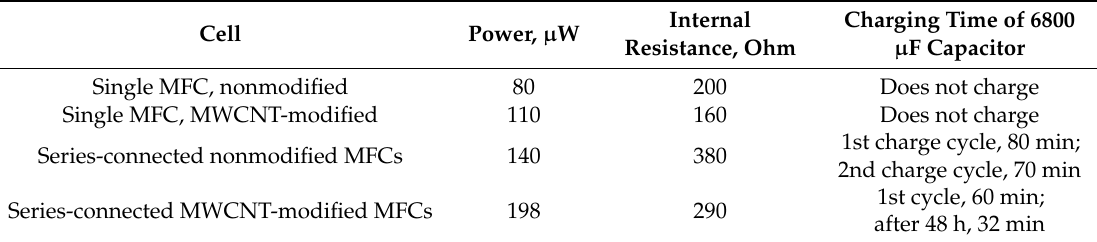
Table 3. MFC characteristics and capacitor charge times.